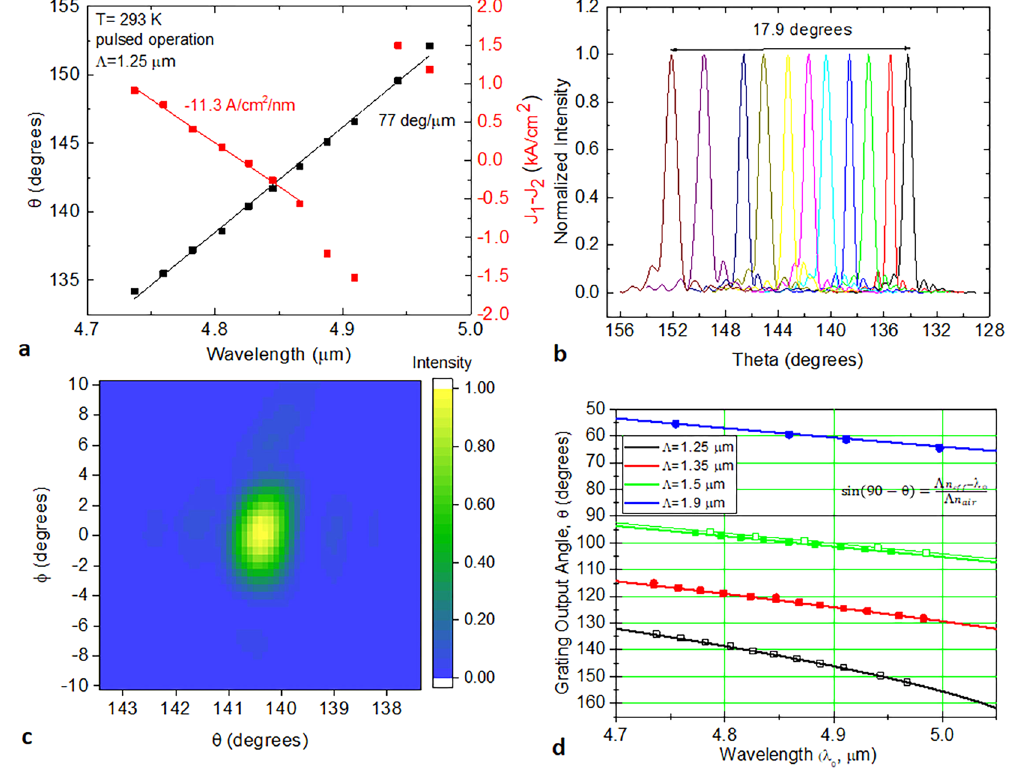
Figure 5. Tuning and steering behaviour for SGDFB lasers with tapered grating outcouplers. ( a ) Steering angle and relative current density in the SGDFB sections as a function of emission wavelength. ( b ) A collection of far- field scans along the theta axis ( φ = 0) for different input wavelengths. ( c ) A two dimensional far-field scan of the tapered grating output beam at λ = 4.83 μ m. ( d ) Comparison of experimental and calculated grating output angles for different input wavelengths and grating periods. Experimental data (symbols) and fit with solid lines following the formula given. Closed symbols = linear gratings. Open symbols = tapered